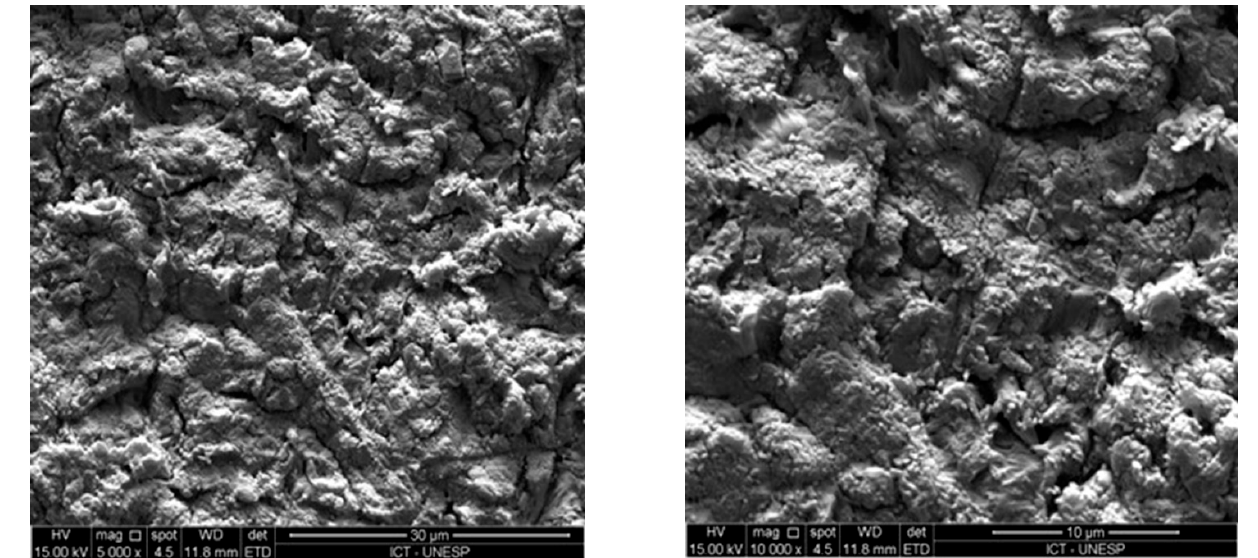
Figure 5. Aluminum oxide group (ALO). Stripping of the surface and roughness promoted by sandblasting with 45 μ m aluminum oxide. Magnification: 5000× and 10,000×.